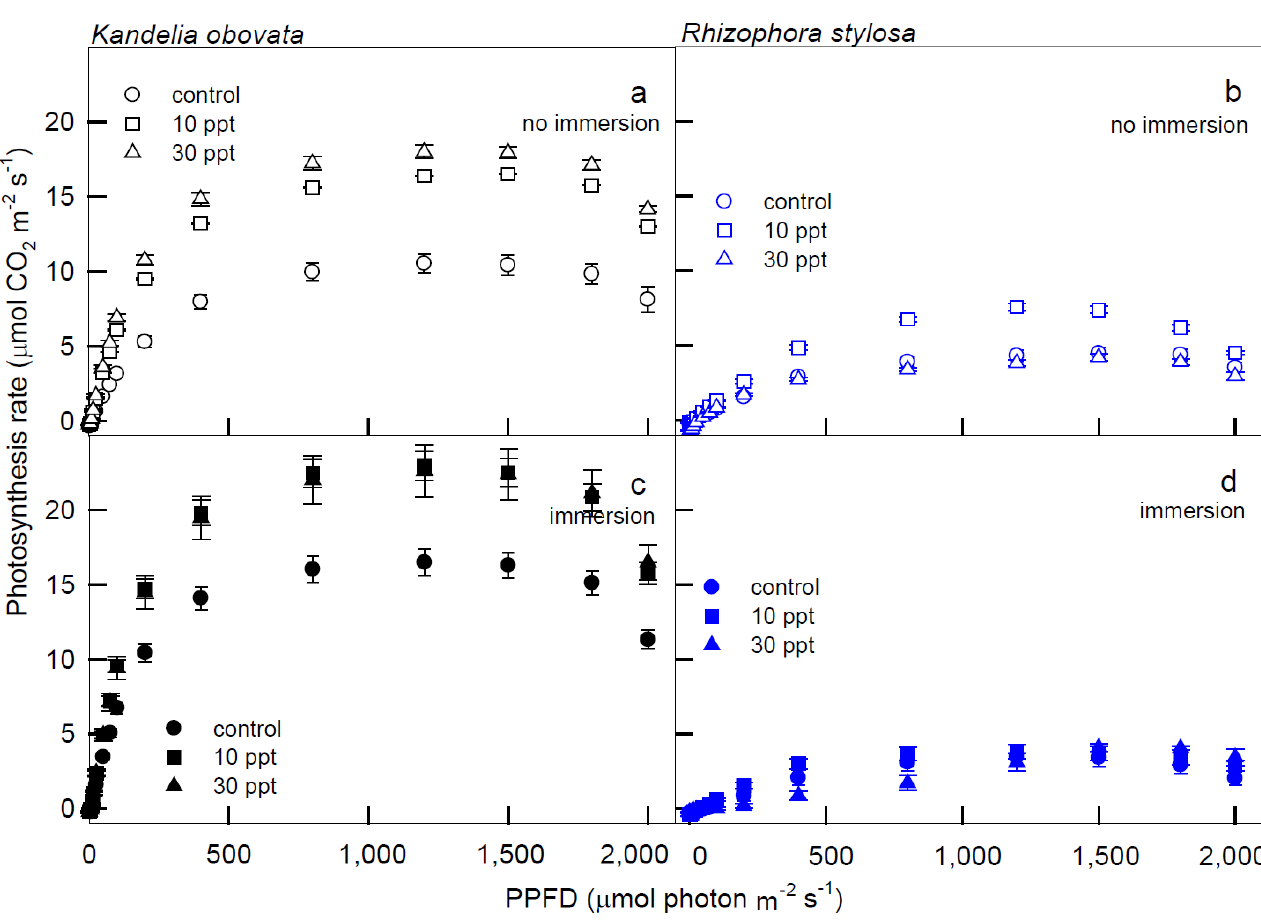
ppt salinity treatment and the control at PPFD > 50 μmol· m −2 ·s −1 (Figure 2b,d).